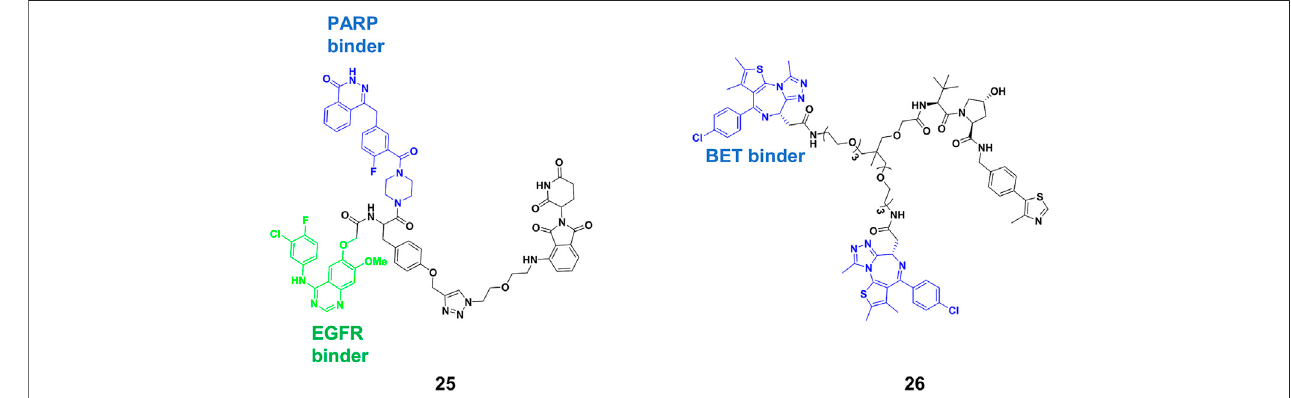
FIGURE 8 | Chemical structure of trivalent PROTACs.